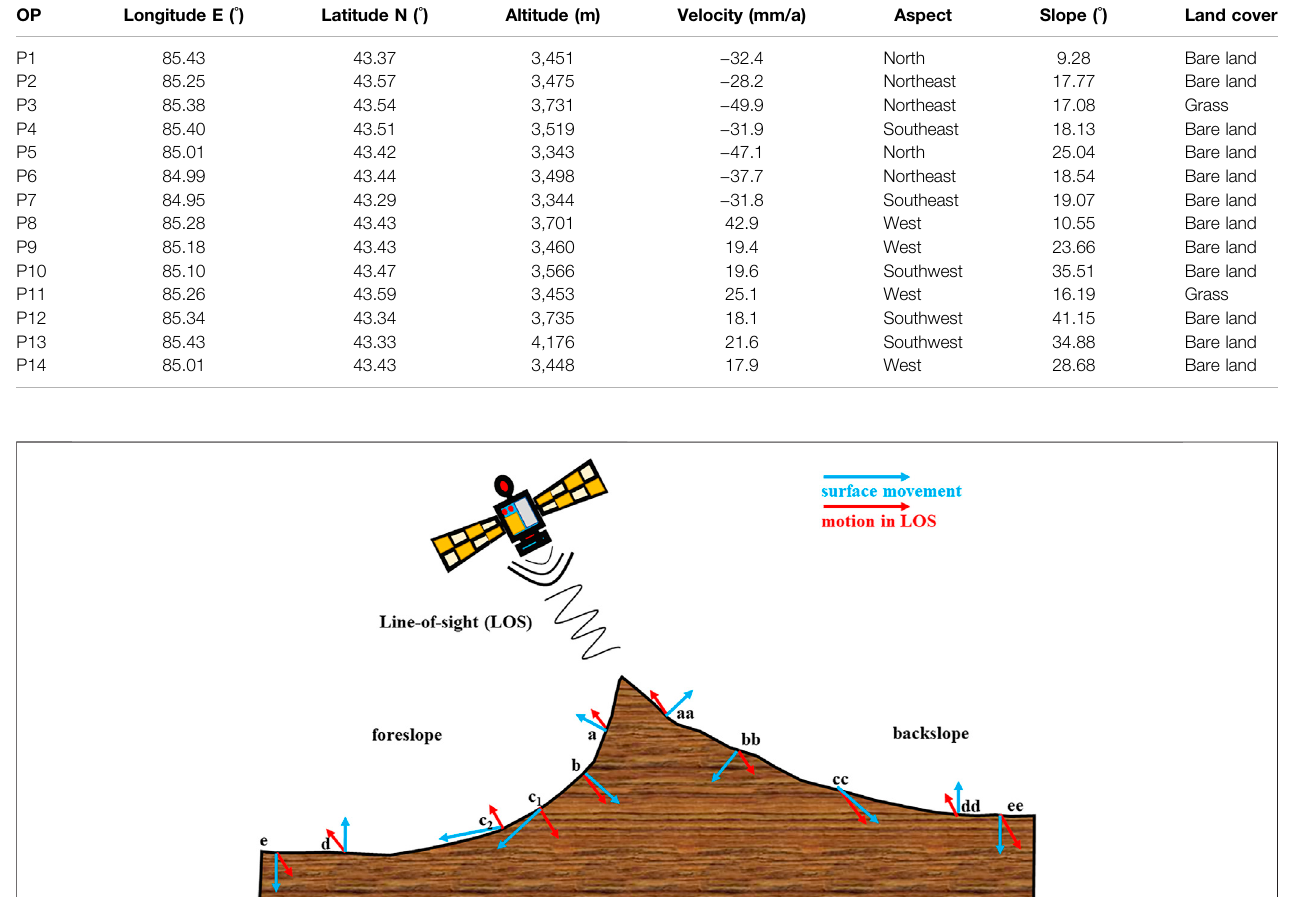
Frontiers in Earth Science |